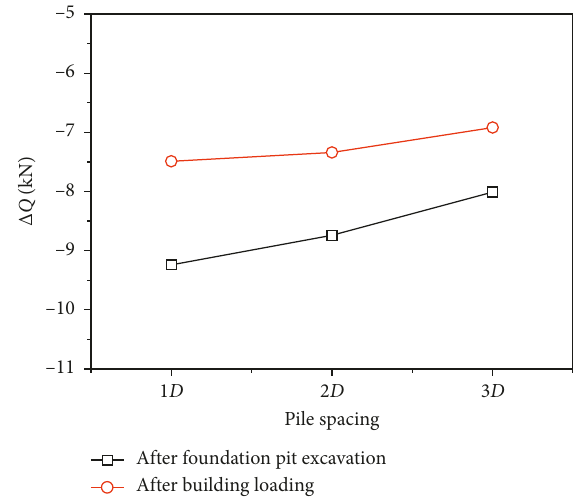
Figure 37: Difference between the additional shear